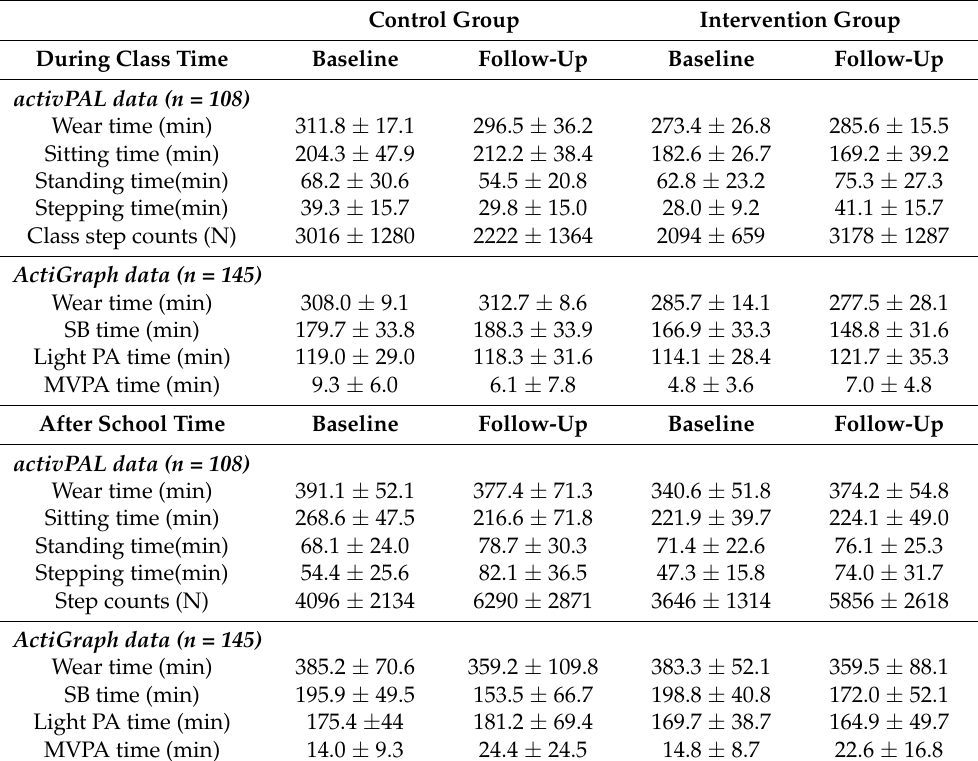
Table 2. Device-measured behaviour (mean ± SD) at baseline and follow-up. Control Group Intervention